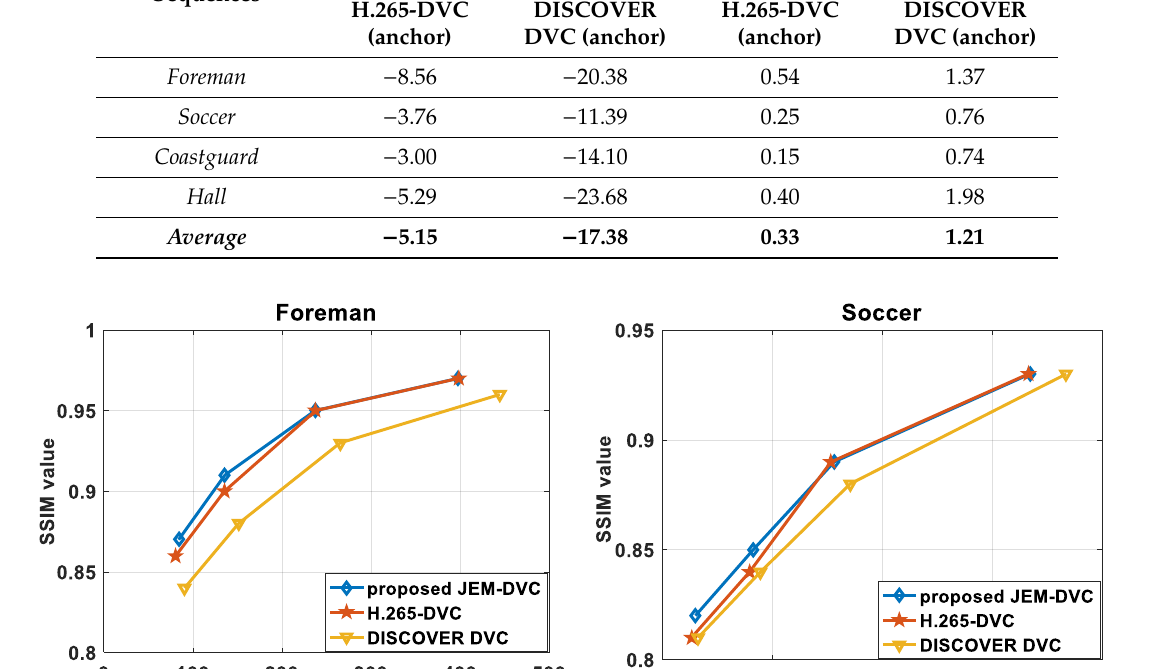
Figure 11. Comparisons of overall rate-distortion (RD) performance obtained by H.265-DVC, DISCOVER DVC, and the proposed JEM-DVC with different test sequences: ( a ) Foreman , ( b ) Soccer , ( c ) Coastguard , and ( d ) Hall Monitor .